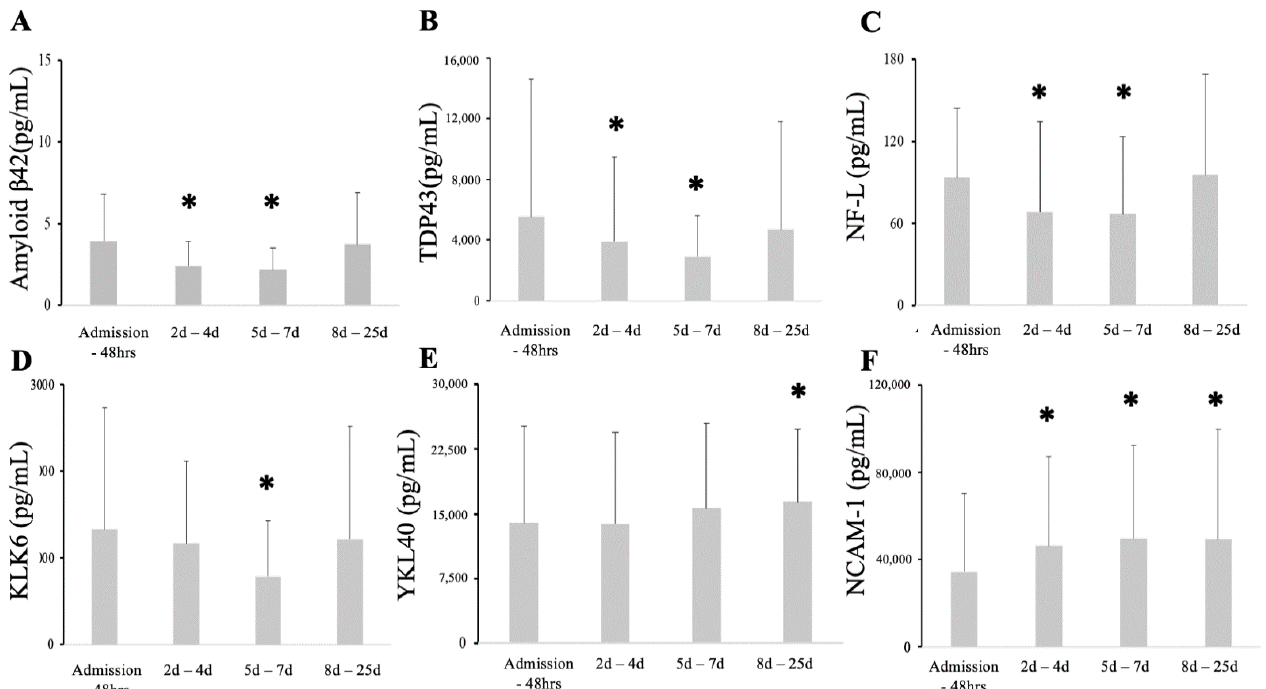
Figure 2. Amyloid β 42, TDP43, and NFL serum levels diminished shortly after admission to recover at 28 days ( A – C ). KLK6 decreased significantly at seven days, then recovered to baseline levels ( D ). Serum YKL40 increased in sample taken more than 7 days after admission ( E ). NCAM-1 significantly and sustainably increased afteno, it should pr admission ( F ). * Statistical difference when compared to all patients at admission.